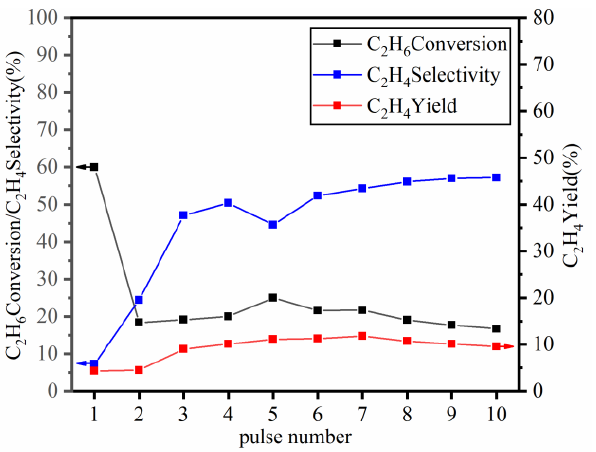
Figure 6. The 0.2LCMO continuous pulse experiment at 700 ° C (GHSV = 1200 mL/h·g).